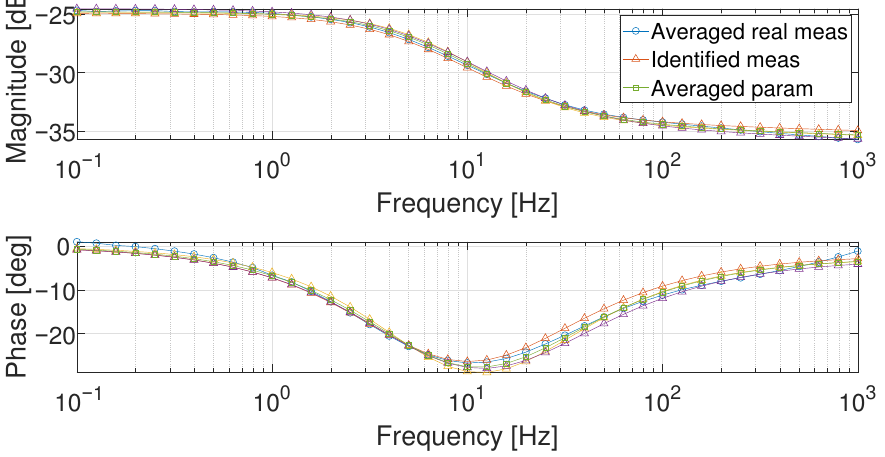
Figure 15. Comparison of the Bode diagrams obtained with the real averaged measurement (circle marker), the model obtained on a single measurement (triangle markers, three curves), and that obtained with the averaged parameters (square marker) at 1A.